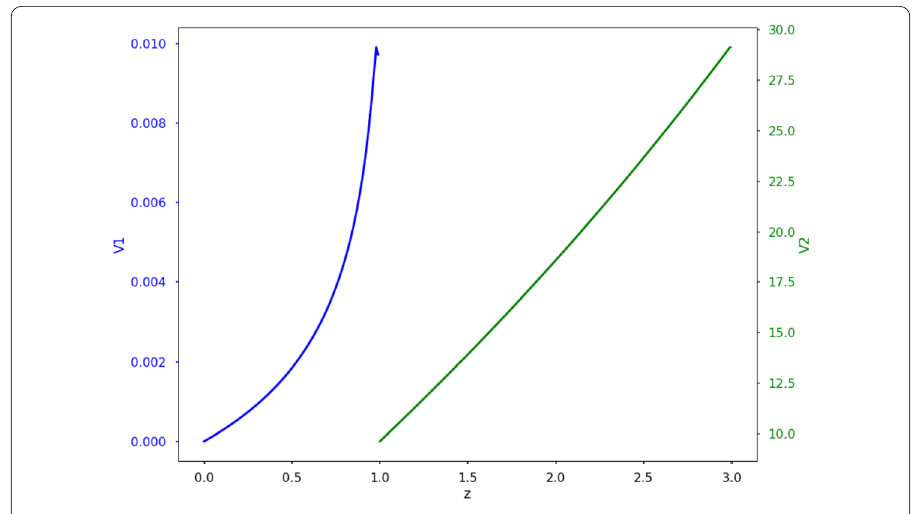
Figure 1 The solution of equation